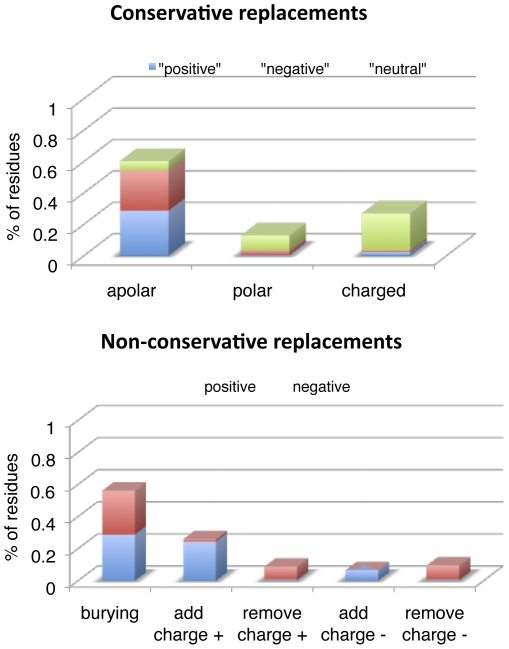
Expected structural effect of the 305 residue replacements found between the two alvinellid species in ribosomal proteins.Putative positive (blue bar), neutral (green bar) or negative (red bar) effect in terms of solvant exposure and charge modification on the 3D predicted structure of the 49 complete orthologous ribosomal proteins retrieved from the two alvinellid species. Replacements have been categorized into (above) conservative (i.e. polar to polar or apolar to apolar) and (below) non-conservative changes (i.e. polar to apolar or apolar to polar). Positive or negative effect was defined following three criteria: the level of residue burial when exposed or buried in the protein, the formation of hydrogen bonds and the formation of electrostatic bonds or exposed charges. (Above) Distribution of conservative changes from P. grasslei to A. pompejana between apolar, polar and charged residues. In the apolar category, positive = increase of the residue volume, negative = decrease of the residue volume and neutral = no volume change. In the charged and polar categories, positive = bond addition and negative = bond removal. (Below) Distribution of non conservative changes from P. grasslei to A. pompejana in terms of residue burial, hydrogen bonds, electrostatic bonds and solvation (positive: buried at a buried position or exposed at an exposed position, addition of hydrogen or electrostatic bonds, charged at exposed positions, negative: buried at an exposed position or exposed at a buried position, removal of bonds).